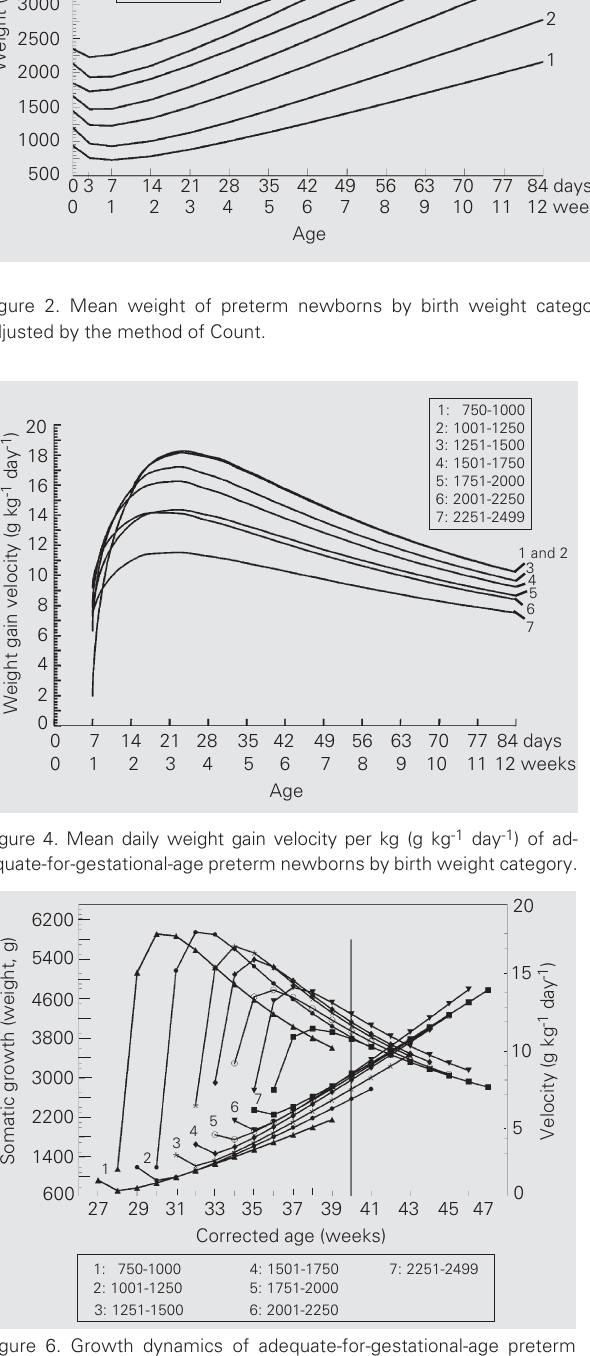
Figure 6. Growth dynamics of adequate-for-gestational-age preterm newborns: somatic growth and velocity with respect to corrected